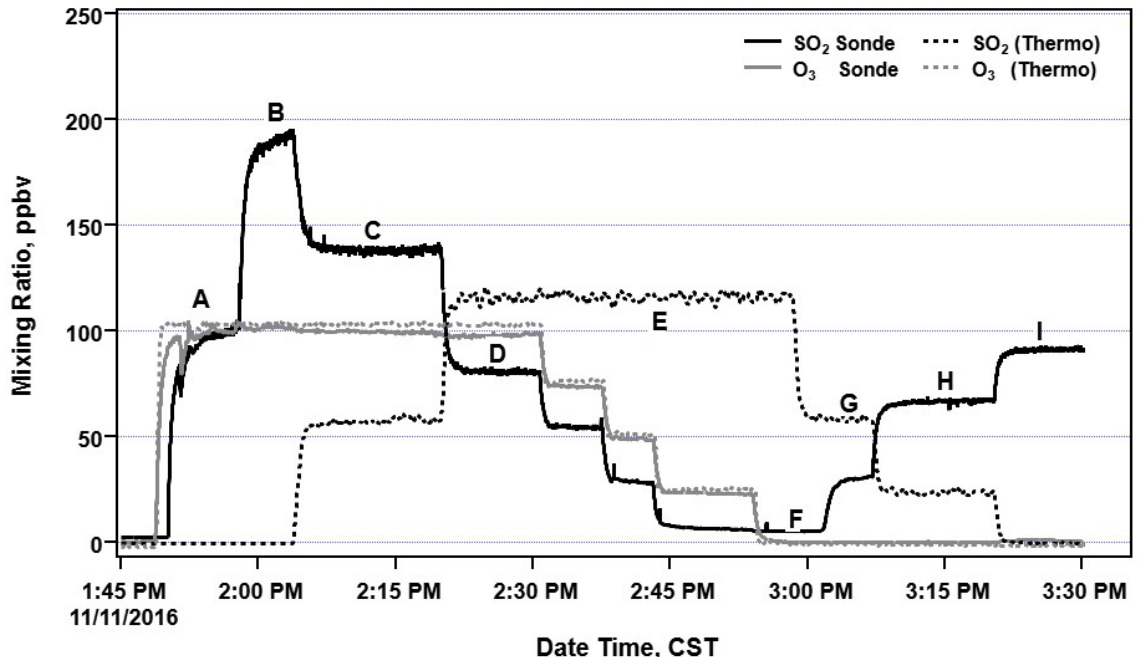
Figure 1. Test of the SO 2 sonde v1.0 (without an O 3 removal filter) with an applied bias current responding to O 3 and SO 2 . See the text for further details.